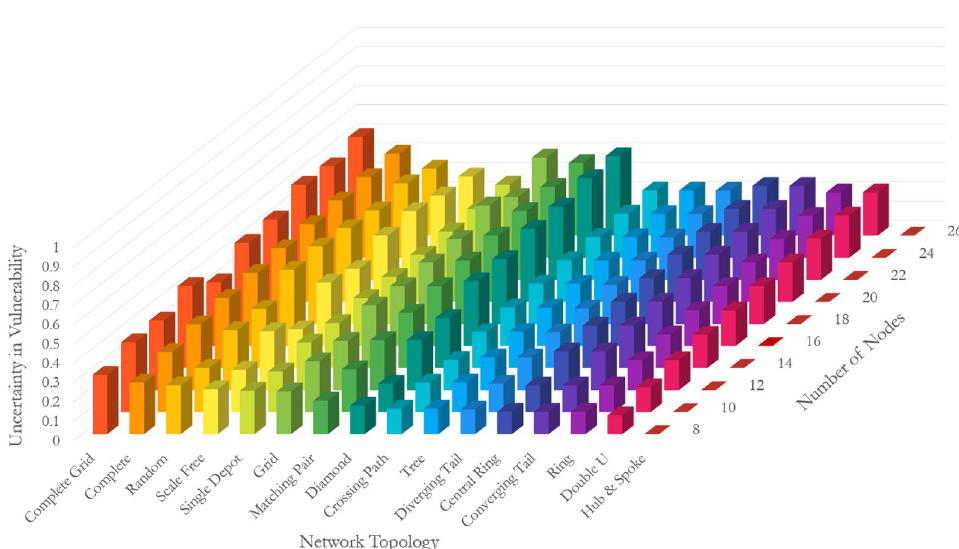
Figure 4. Uncertainty in the vulnerability of networks with different topologies and